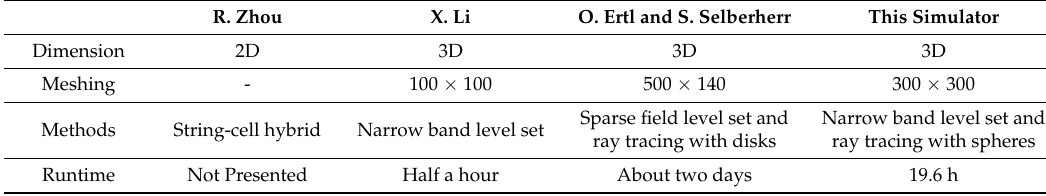
Table 1. Comparisons among the different simulators for the Bosch process.